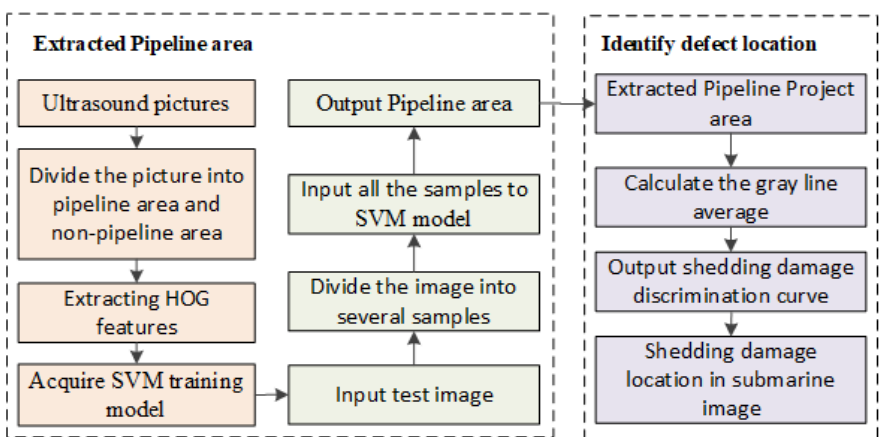
Figure 4. Flow of shedding damage detection.